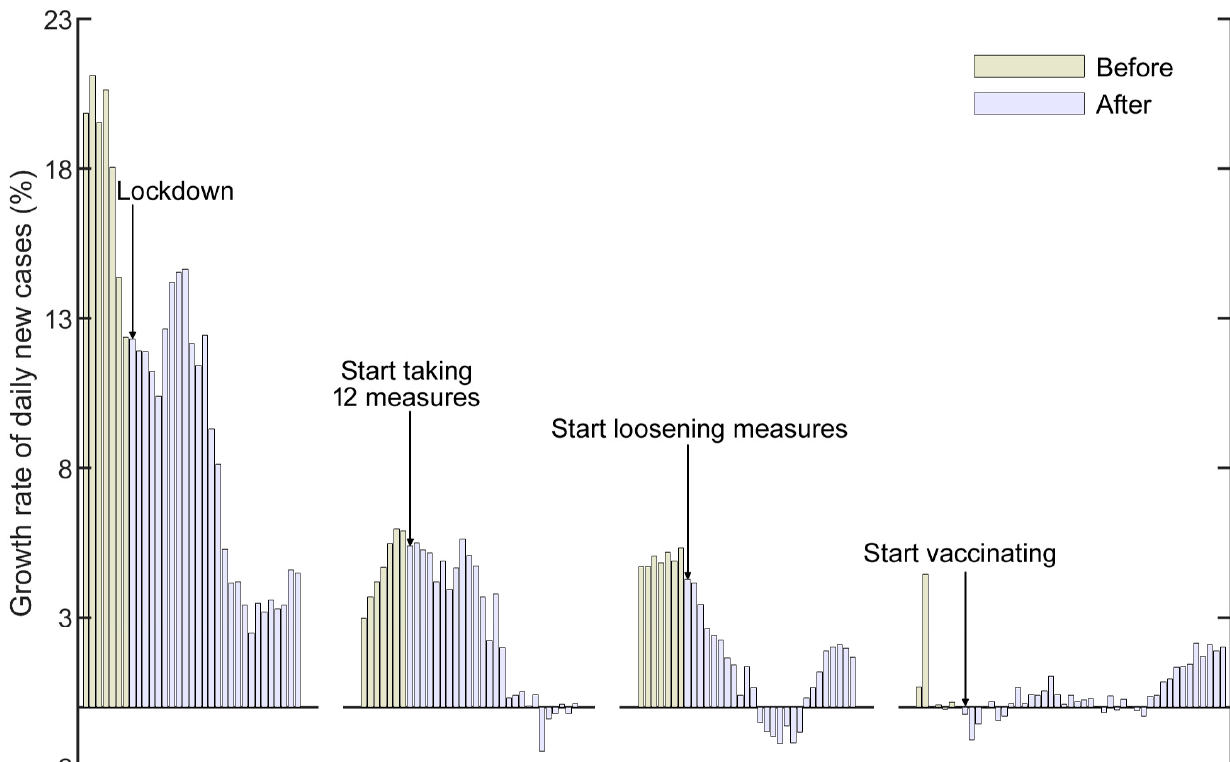
Figure 3. Weighted average growth rate of daily new cases for 18 countries (except for Maldives due to data shortage) in South and Southeast Asia. Pale yellow and light purple represent values before and after the implementation of lockdowns and 12 measures (C1–C8 and H1–H4), loosening of these measures, and introduction of vaccines, respectively.